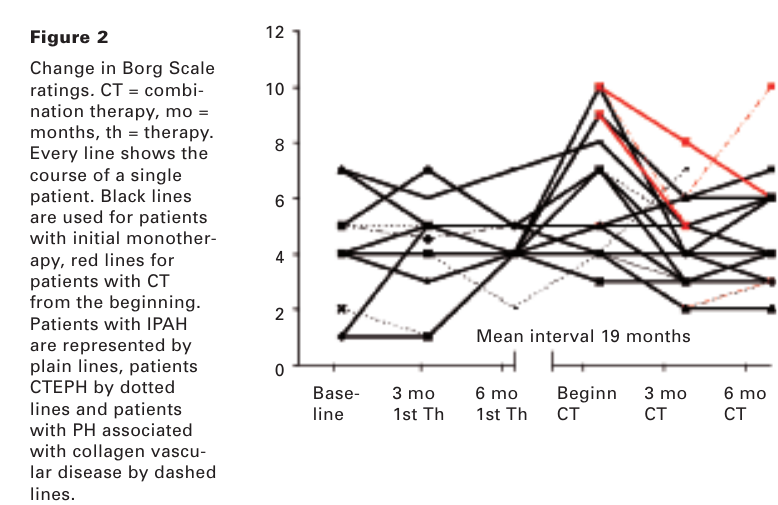
Change in six-minute walk distance. CT = combination therapy, mo = months, th = therapy. Every line shows the course of a single patient. Black lines are used for patients with ini- tial monotherapy, red lines for patients with CT from the begin- ning. Patients with IPAH are represented by plain lines, patients CTEPH by dotted lines and patients with PH associated with colla- gen vascular disease by dashed lines.